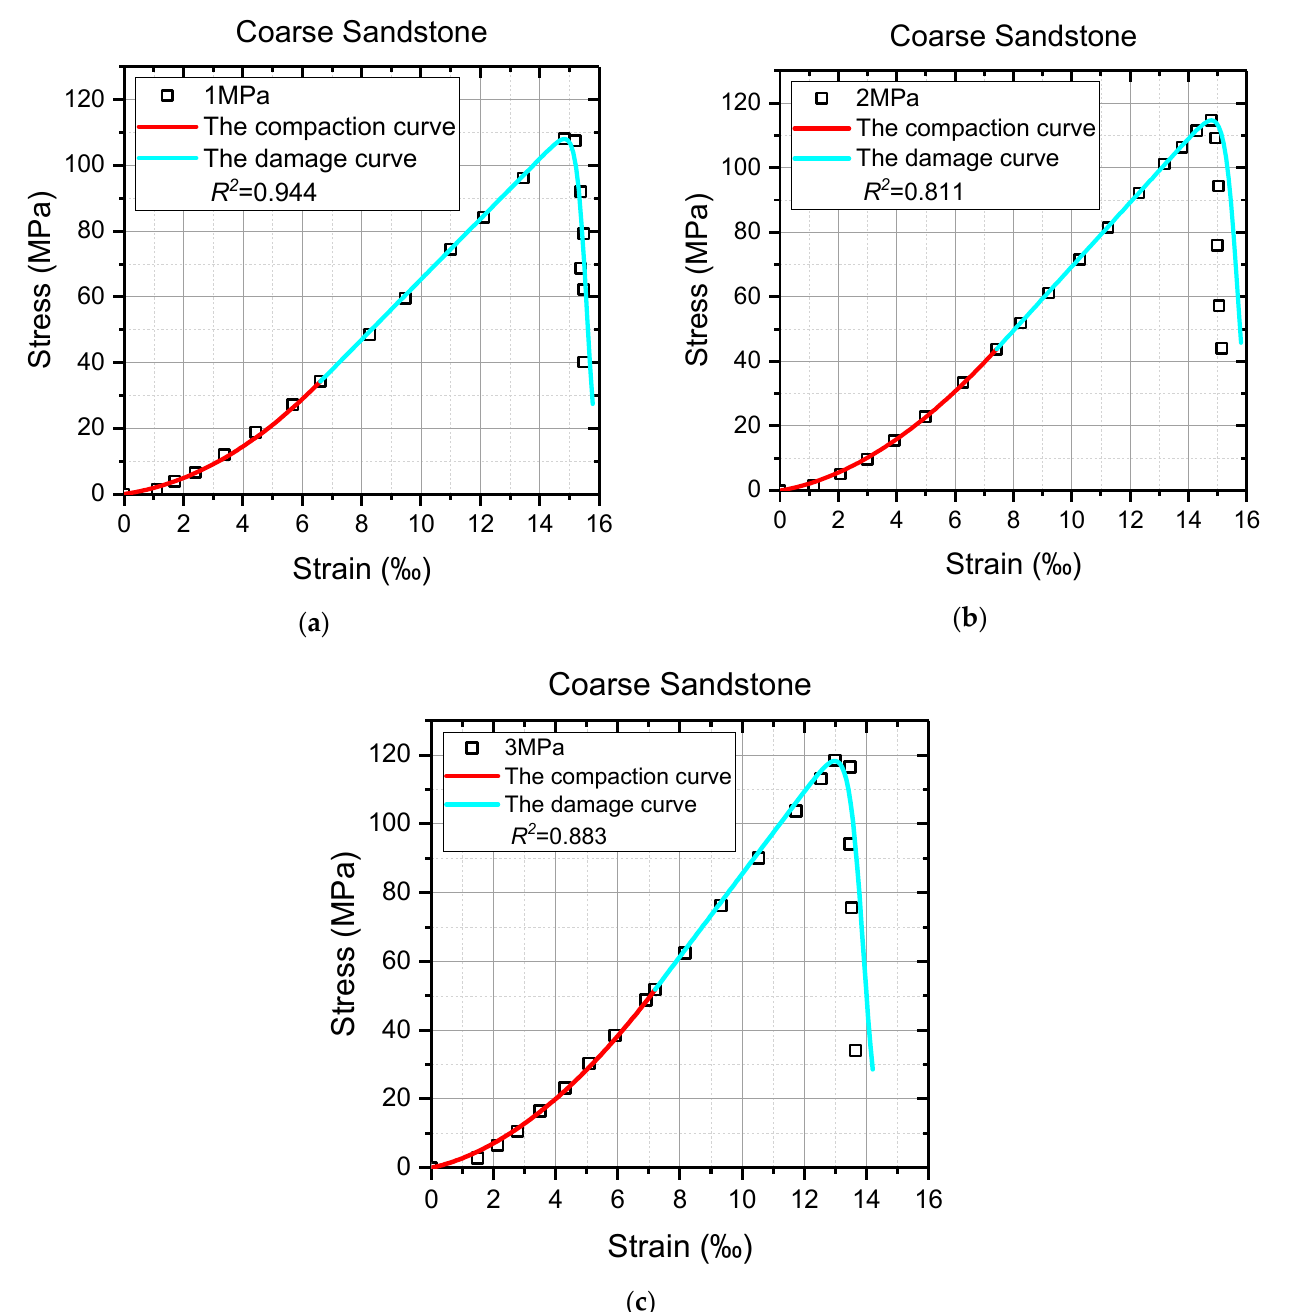
Figure 12. The comparison between partial triaxial test data and model curves of coarse sandstone.